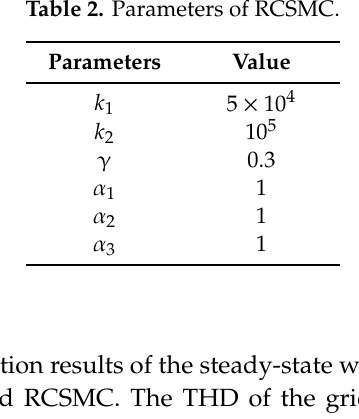
(a) Simulation waveform of i La and i sa (b) Spectrum of i sa Figure 6. Simulation waveform of SAPF based on multi-resonance sliding mode controller (MRSMC) in steady state.